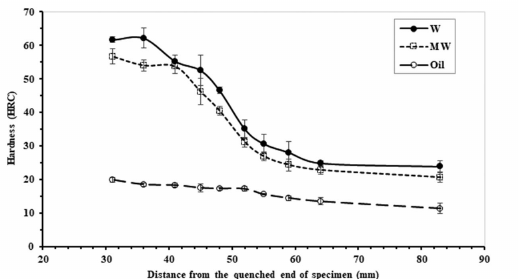
Figure 5. Hardness profiles of S45C steel after quenching only half of each sample by immersing in quenchant: regular tap water(W), magnetically treated tap water (MW), and oil